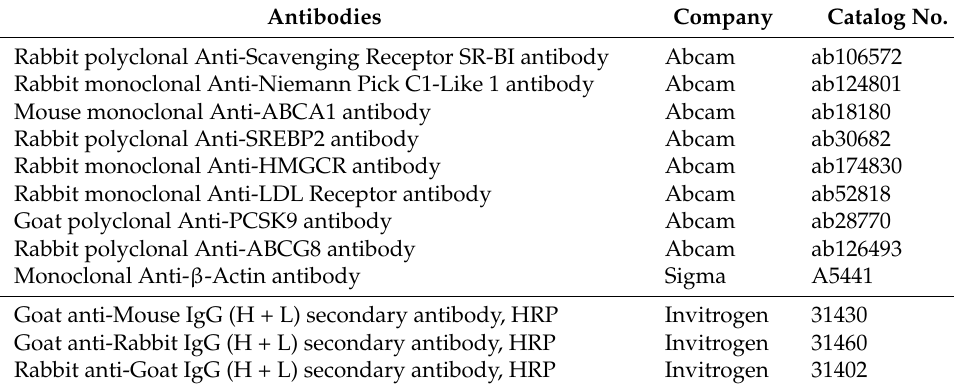
Table 2. Antibodies used for Western